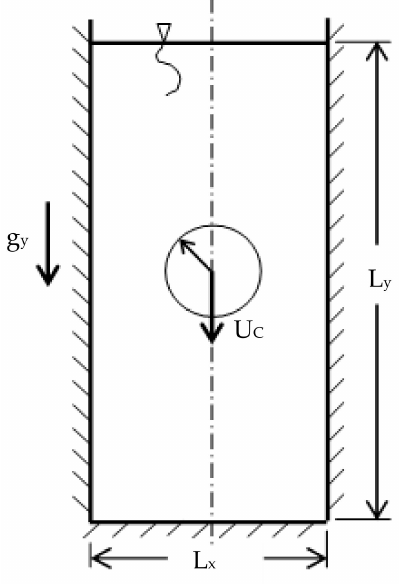
Figure 9. Schematic of the computational domain.